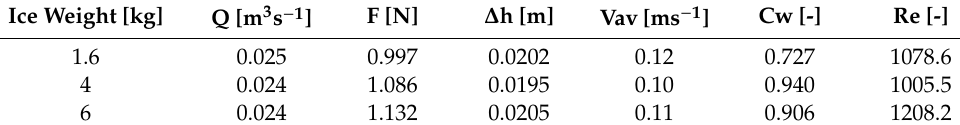
Table 1. Average values of flow rate, drag force and drag coefficient.